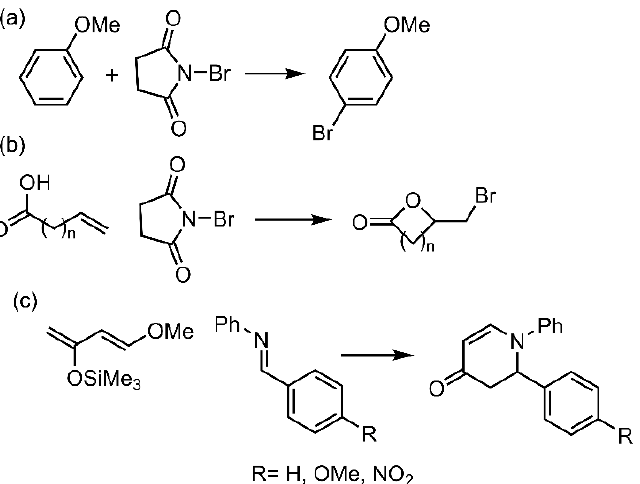
Figure 20. Schematic view of the three benchmark reactions used to evaluate the efficiency of the Te organocatalysts. ( a ) Friedel–Crafts bromination of anisole. ( b ) Bromolactonization of ω -unsaturated carboxylic acids. ( c ) Aza-Diels–Alder reaction between Danisehfsky’s diene and imines.